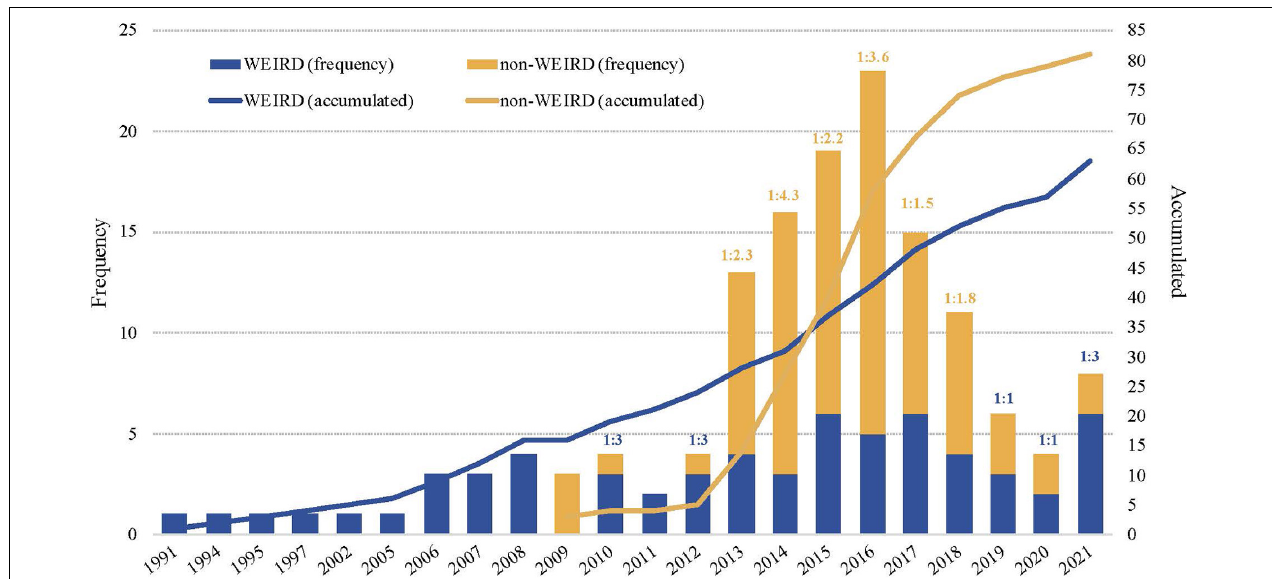
FIGURE 6 | Temporal distribution of publications, accumulated frequency and WEIRD/non-WEIRD publication ratio in RCTs about